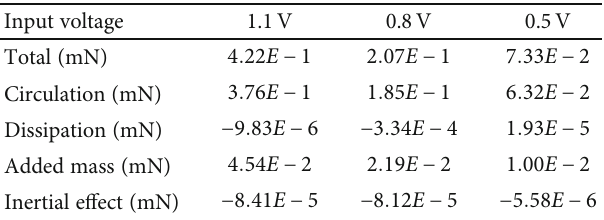
Figure 8: The aerodynamic force along the y 1.1V, (b) 0.8V, and (c) 0.5V. Table 4: Distribution of the mean aerodynamic